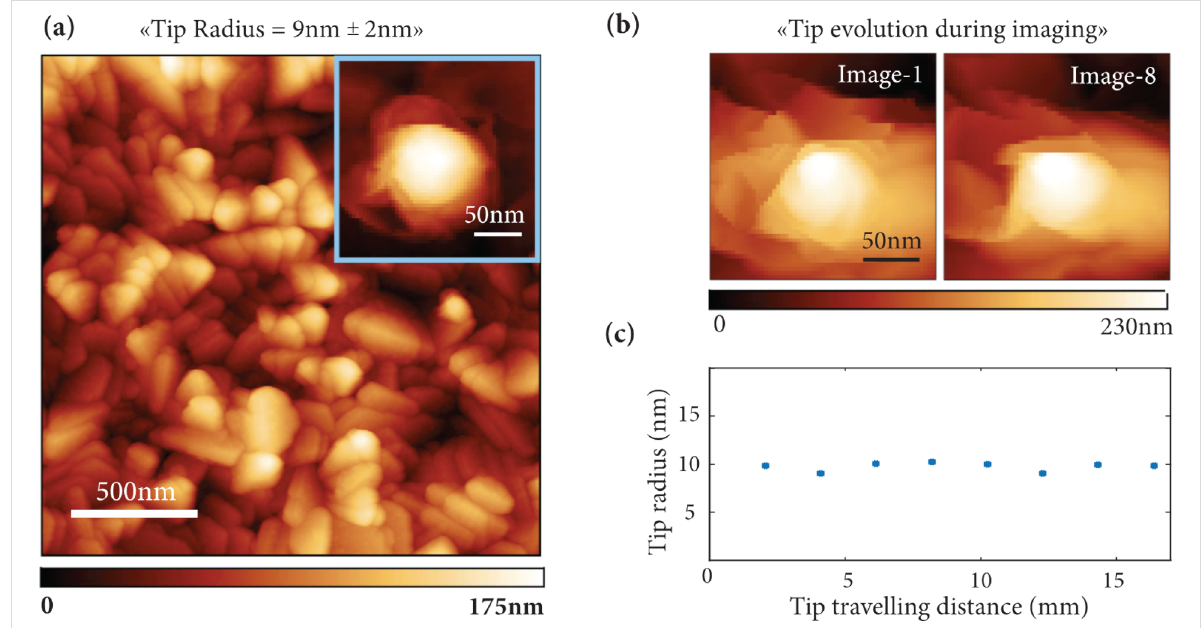
Figure 2: Tip sharpness and durability assessment of the LSNT-tip SU8 cantilevers using a polycrystalline titanium roughness sample in tapping mode. (a) The AFM image of the polycrystalline titanium roughness sample, used for the tip radius measurement. The average tip radius of 20 randomly chosen cantilevers is 9 nm. The image size is 2 × 2 µm at 512 × 512 pixels while the array dimension for the tip estimation is 55 × 55 pixels. The inset shows the result of the Gwyddion partial tip blind estimation extracted from the full image. (b, c) the tip radius evolution over 16 mm travel- ling distance shows negligible tip